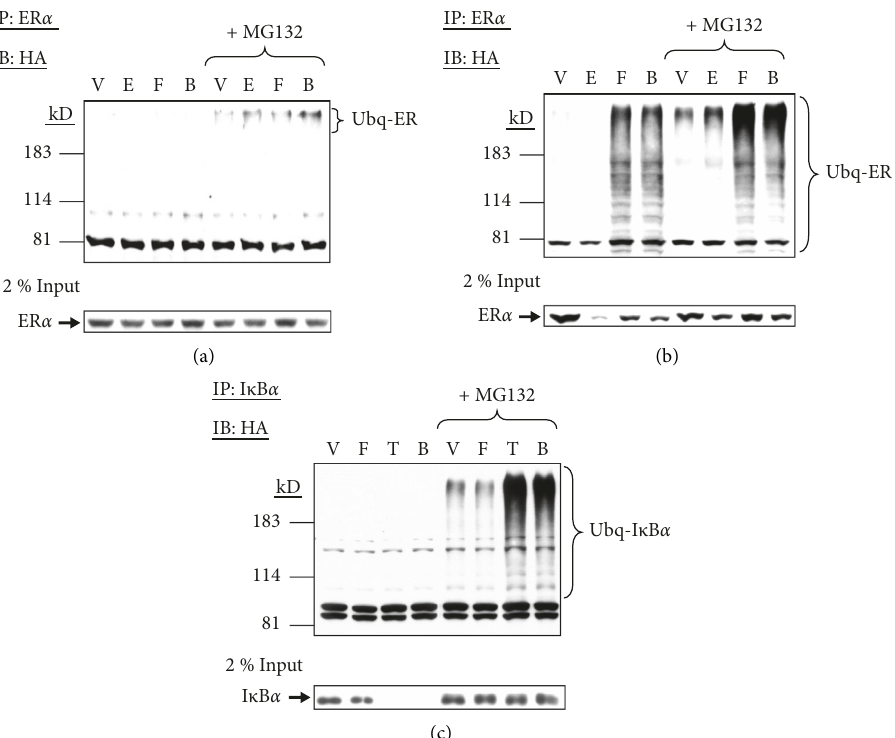
Figure 5: Forskolin increases ER α , but not I κ B α , ubiquitination. (a) GH3 cells were transfected with a HA-tagged ubiquitin expression vector (4 μ g). These cells were pretreated with or without MG132 (40 μ M) for 1h, followed by vehicle (V), estradiol (E, 10 nM), forskolin (F, 1 μ M), or both (B) for 1 h. Cell lysate was immunoprecipitated (IP) with ER α antibody and then immunoblotted (IB) with HA to detect ubiquitinated ER α (Ubq-ER) (upper panel). These lysates were also subjected immunoblotting (IB) for detecting ER α (lower panel). (b) HA- tagged ubiquitin expressing GH3 cells were similarly pretreated with either vehicle or MG132 for 1h followed by vehicle (V), estradiol (E), forskolin (F), or both (B) for 6h. As described above, cell lysates were similarly immunoprecipitated (IP) for ER α and then immunoblotted (IB) for HA to detect ubiquitinated ER α (Ubq-ER) (upper panel) as well as immunoblotting (IB) for ER α in parallel (lower panel). (c) GH3 cells were similarly transfected with HA-tagged ubiquitin expression vector, pretreated with MG132, and then treated with vehicle (V), forskolin (F), TNF α (T, 100ng/ml), or both (B) for 15 min. Cell lysate was immunoprecipitated (IP) with I κ B α antibody and then immunoblotted (IB) with HA to detect ubiquitinated I κ B α (Ubq-I κ B α ) (upper panel). I κ B α was also detected by immunoblotting (IB) in these lysates (lower